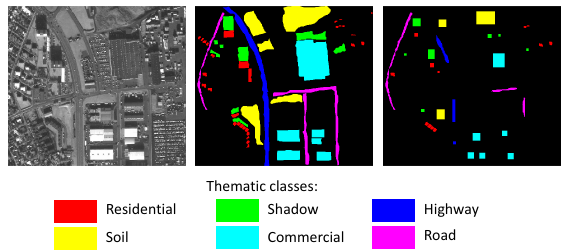
Figure 7. The Reykjavik data of size 628 × 700 pixels (left to right: panchromatic, thematic ground truth with 6 classes and training set)